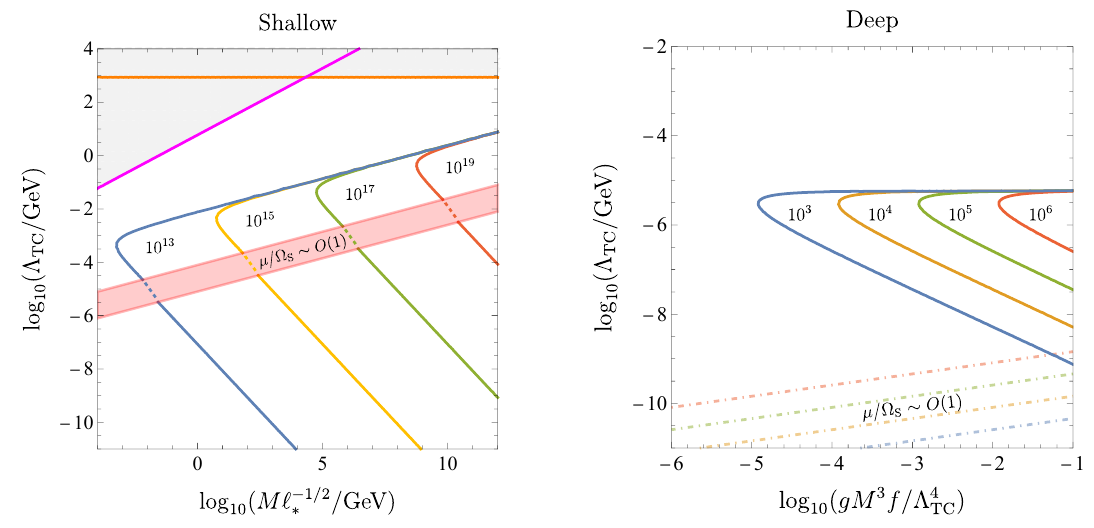
Figure 4 . Regions excluded (inside labelled lines for several values of f [GeV] ) by the formation and escape of a TC relaxion bubble induced by the electromagnetic fields generated by rotating neutron stars. Left panel: for a bubble connecting shallow minima, δ 2 (cid:28) 1 or equivalently Λ band shows µ ∼ Ω for a critical bubble. Right panel: for a bubble connecting deep minima, the depth S parametrized by gM 3 f/ Λ 4 = 1 − δ 2 . Dot-dashed lines show µ ∼ Ω TC stant. Note the different range for Λ (recall for shallow minima Λ TC